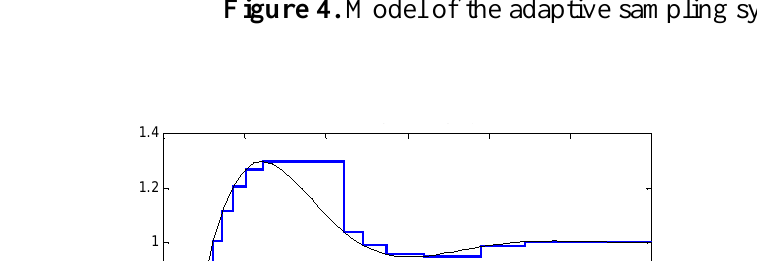
Figure 4. Model of the adaptive sampling system.